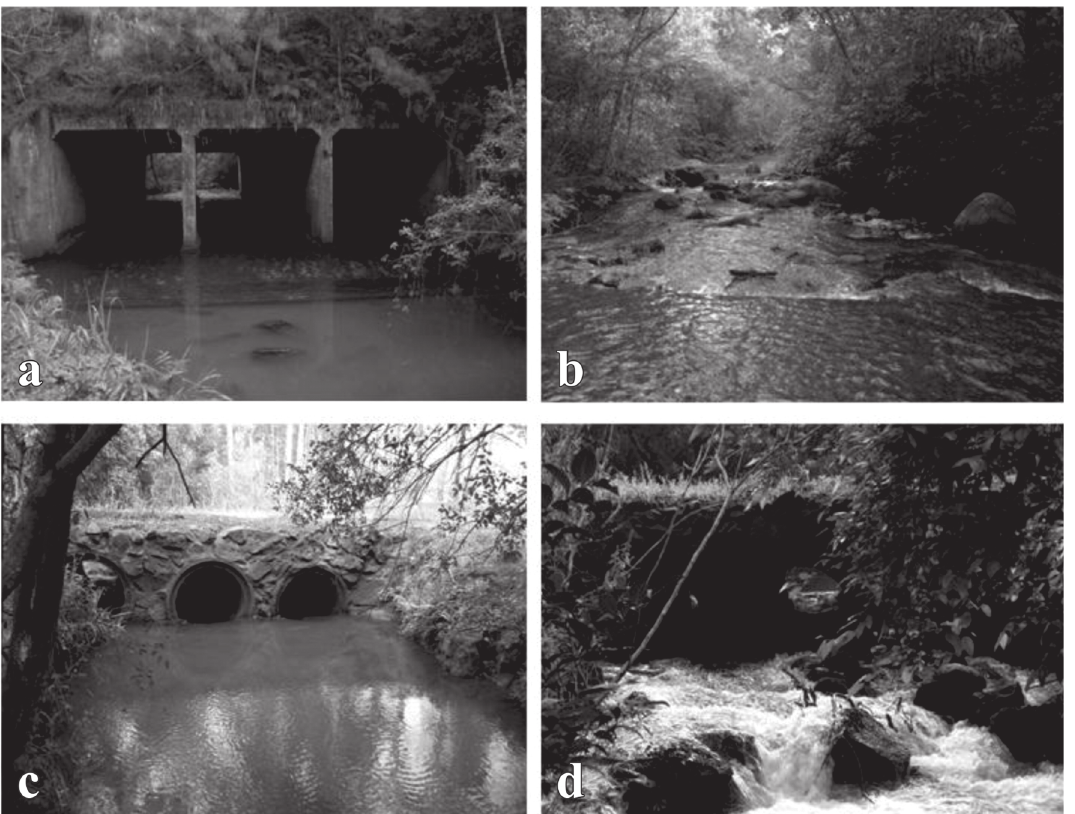
Fig. 2. Sampled stretches: Pindorama stream: a ) upstream and b ) downstream from box culvert, and Lopeí stream: c ) upstream and d ) downstream from circular culvert.